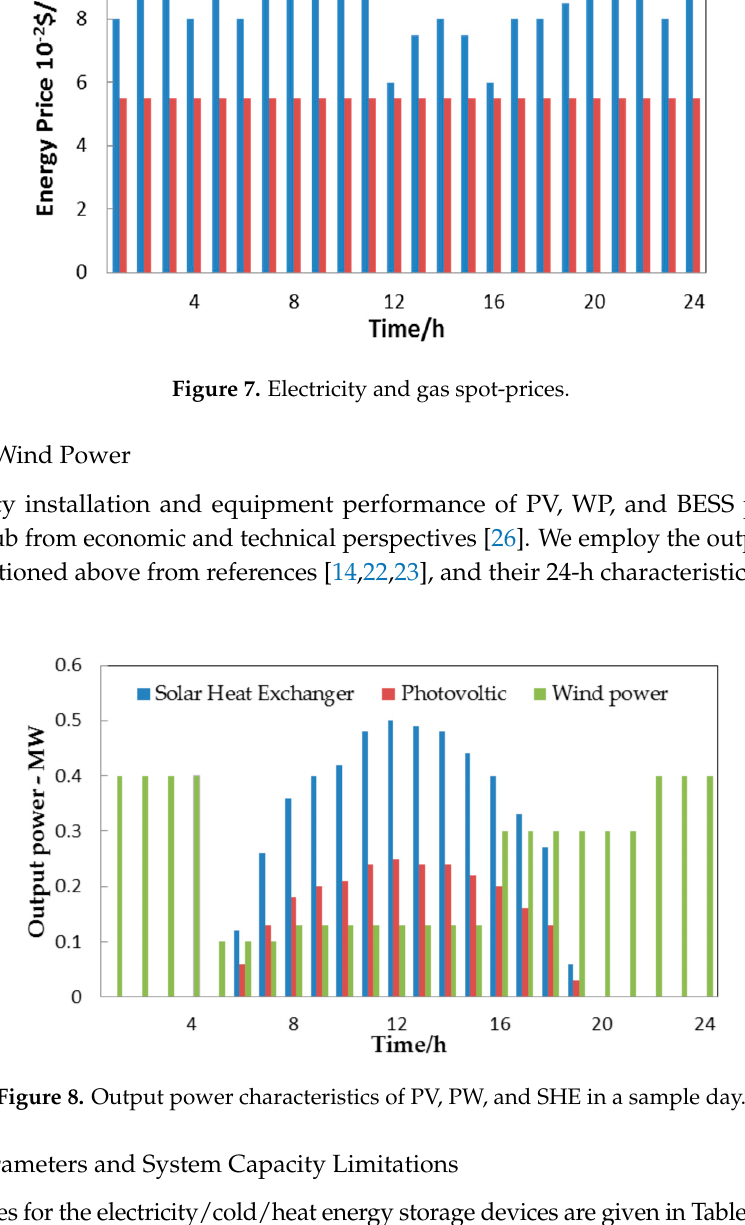
Table 1. Parameters for Energy Storage Devices.